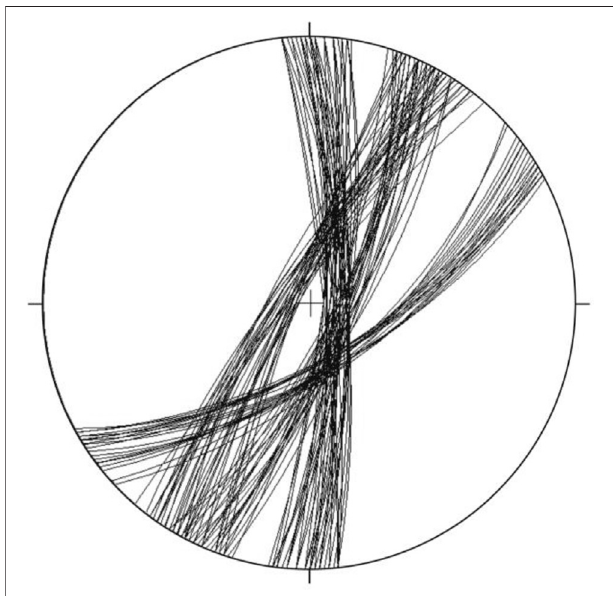
FIGURE 4 | Orientation of fracture in the Xike ’ er reverse fault. Four groups of fractures are developed in the Xike ’ er reverse fault.